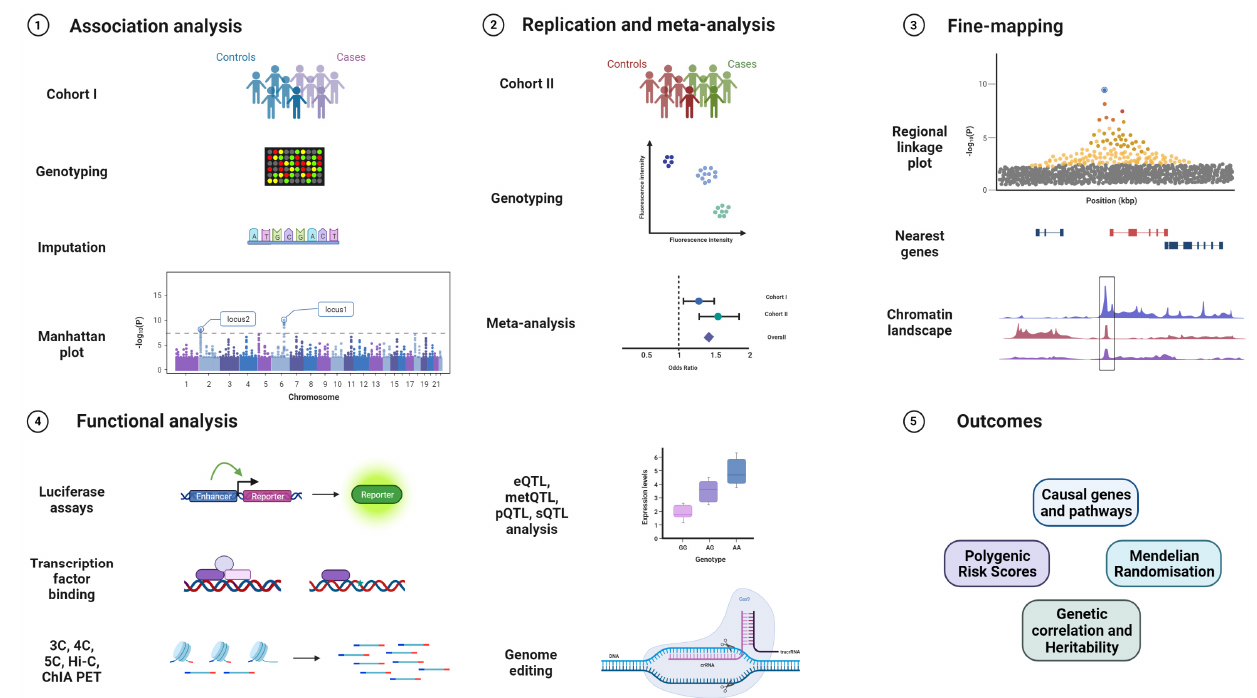
Figure 2. GWAS workflow from replication, validation, fine-mapping, and identifying biological mechanisms to clinically relevant outcomes. The various stages of a genome-wide association study, starting from genotyping on custom arrays, imputation on reference genomes, association analysis, and visualisation, followed by replication in an independent cohort, validation genotyping, and meta-analysis. The top loci are then fine-mapped and integrated with bioinformatic annotations before proceeding to functional experiments in relevant cell and tissue types such as promoter and enhancer luciferase assays, ChIP, 3C, 4C, 5C, Hi-C, ChIA-PET, eQTL analysis, and genome editing via the CRISPR/Cas system. Expected outcomes are the identification of relevant genes and pathways affected by the variant, and extraction of polygenic risk scores (PRS), Mendelian randomisation (MR), and genetic correlation with other traits.